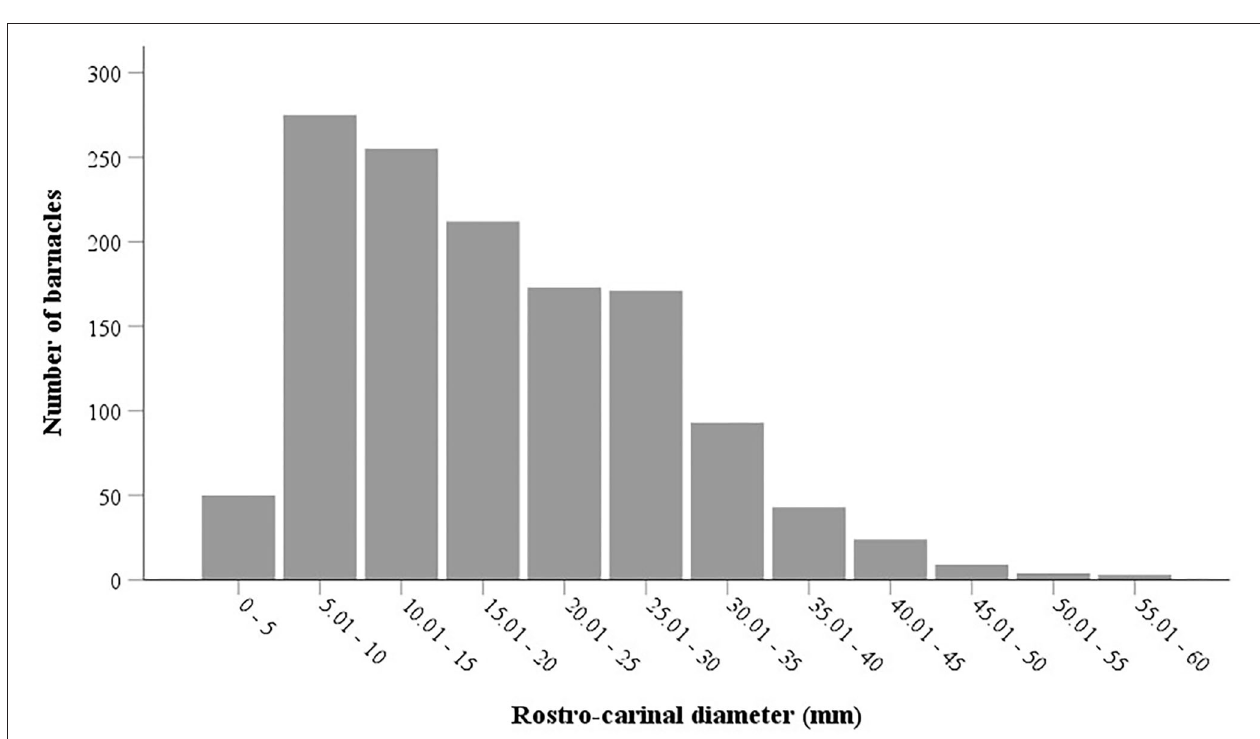
FIGURE 6 | Size frequency distribution of the barnacle Chelonibia testudinaria on different body surfaces of the hawksbill sea turtles nesting on Shibderaz and Dayyer-Nakhiloo National Park (DNNP).